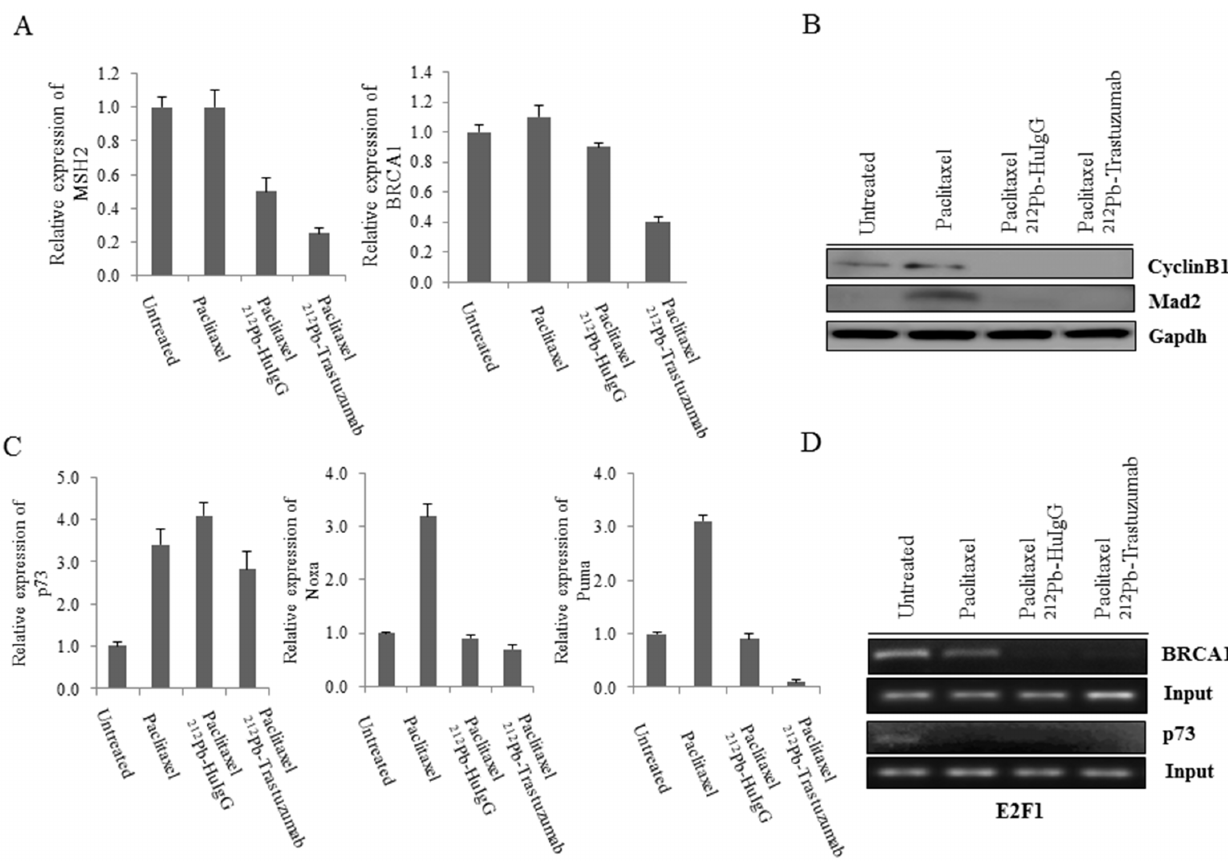
Figure 1. Expression of BASC (BRCA1-associated genome surveillance complex) related genes and p73 expression in response to Pac/ 212 Pb-trastuzumab. Mice bearing i.p. LS-174T xenografts were treated by Pac/ 212 Pb- trastuzumab for 24 h. A. Expression of MSH2 and BRCA1 was determined by RT-PCR. Results represent the average of a minimum of three replications. B. Immunoblot analysis for MAD2 and CYCLIN B1 was performed with tumor collected 24 h after Pac/ 212 Pb-trastuzumab treatment. MAD2 and CYCLIN B1 were detected 22 kDa and 48 kDa, respectively. Equal protein loading control was GAPDH. C. Expression of p73, NOXA , and PUMA was determined by RT-PCR. Results represent the average of a minimum of three replications. D. Binding abundance to E2F1 was determined by ChIP using specific primers for p73 and BRCA1 .